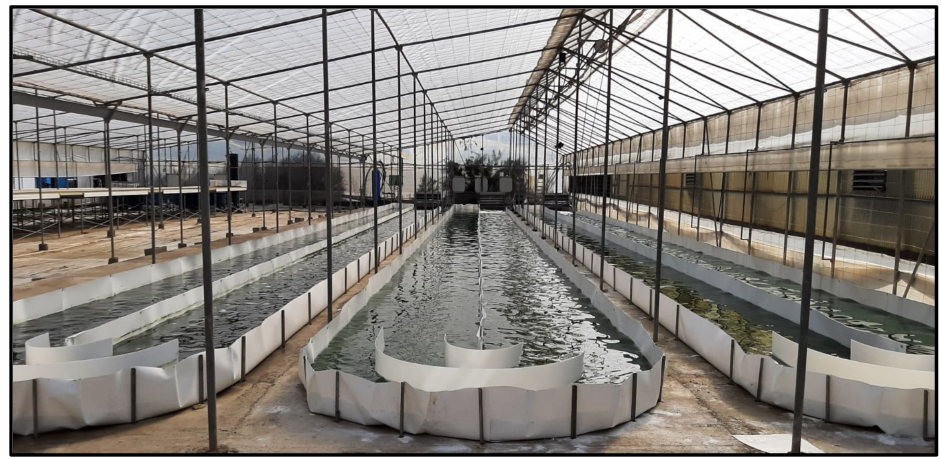
Figure 1. Pilot-scale raceway reactors located inside a greenhouse in Almer í a,